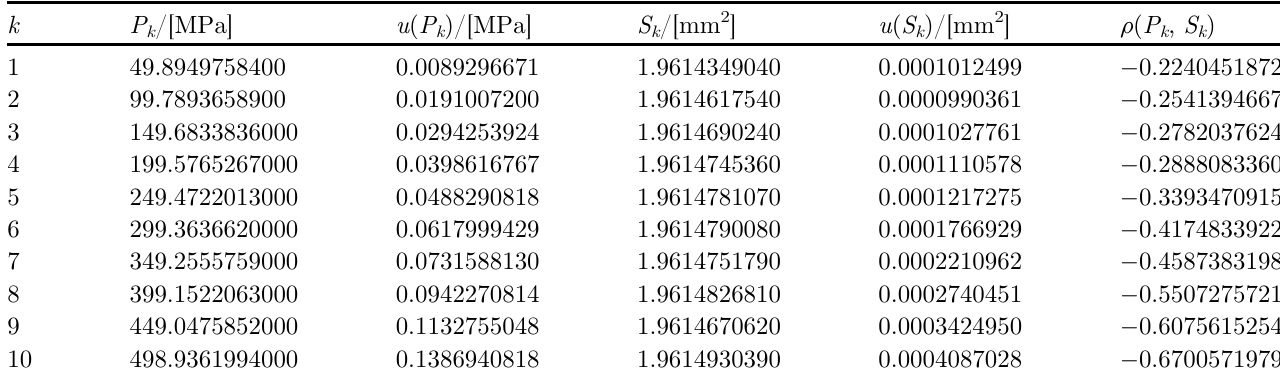
Table 1. Statistical data for pressure balance cross- fl oating measurements for pressures P and areas S in approximate k k = 50 MPa through to P = 500 MPa. The above data is suf fi cient to use as an input equal steps with k = 1, … , 10 from P 1 10 for the WTLSC algorithm and produces essentially the same quality of results as a full GLS Monte Carlo simulation. If the , S ) is unknown or cannot be otherwise estimated it may be set to zero and the dimensionless correlation term r ( P k k WTLSC algorithm will equivalently reproduce the results from a WLS algorithm which provides conservative estimates for the corresponding parameter expected values and associated variances/covariance. It should be noted that a zero correlation of the input/output data will in general still produce a non-zero correlation in the parameters to account for and model the coupling effect between the parameter random